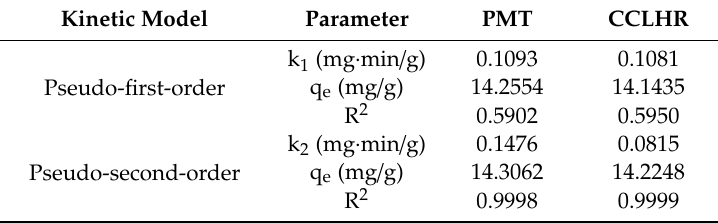
Table 4. Comparison of the pseudo-first-order and pseudo-second-order models for the biosorption of MB on PMT and